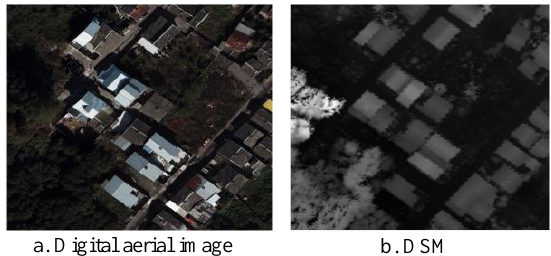
Figure 1. The study area: a. Digital Aerial image, b. DSM